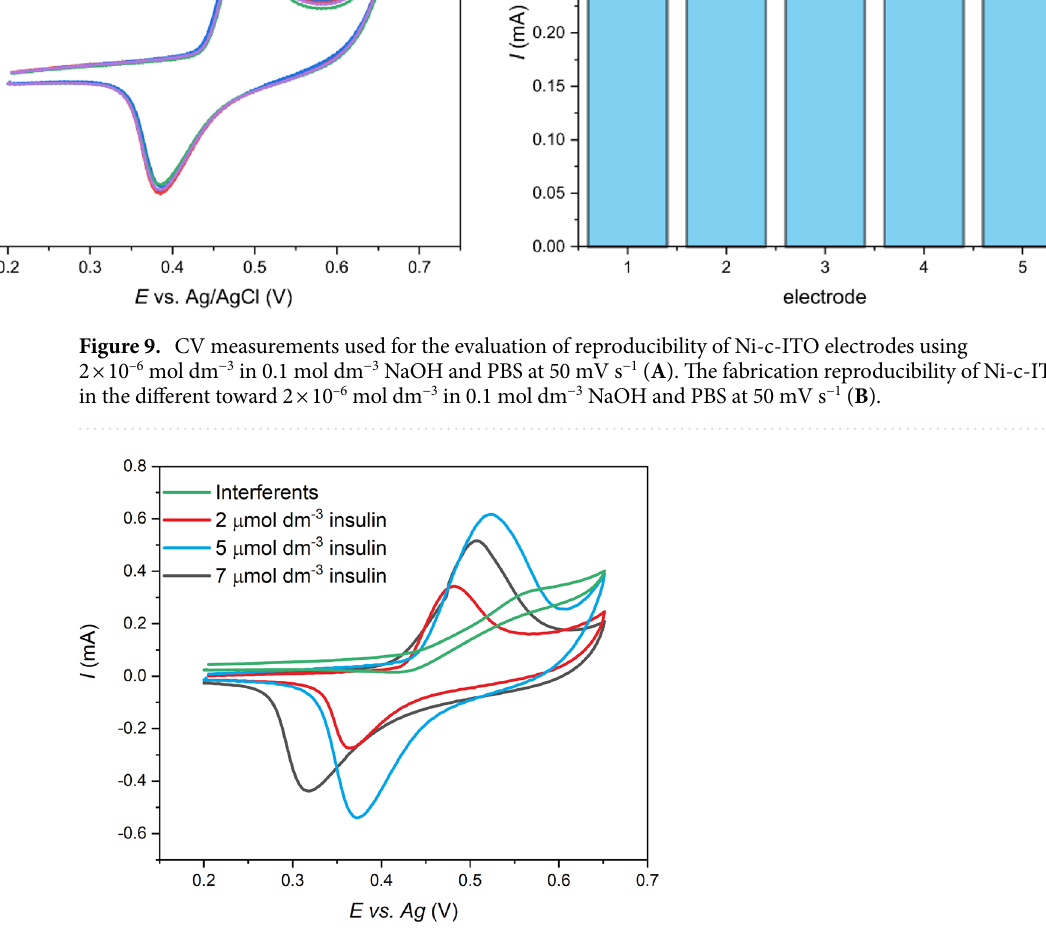
Figure 10. CV curves obtained in the presence of different interferences in the 0.1 mol dm −3 NaOH and PBS (5 × 10 –3 mol dm −3 glucose, 0.1 × 10 –3 mol dm −3 ascorbic acid, 0.1 × 10 –3 mol dm −3 sucrose, 83 × 10 –6 mol dm −3 threonine, 78 × 10 –6 mol dm −3 tyrosine and 0.5 × 10 –3 mol dm −3 uric acid) without insulin (green line) and with 2 × 10 –6 mol dm −3 (red line), 5 × 10 –6 mol dm −3 (black line), and 7 × 10 –6 mol dm −3 (blue line) insulin at 50 mV s −1